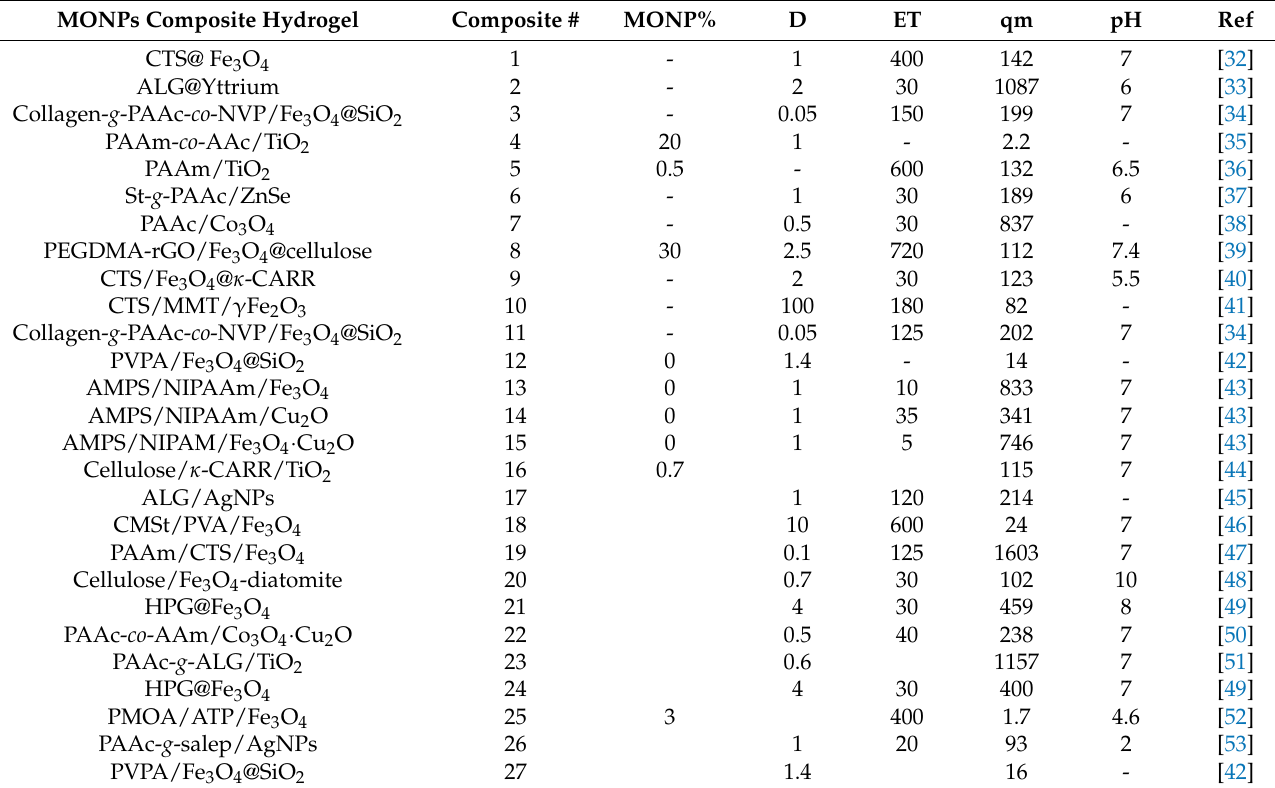
Table 1. Physical and chemical properties data of different composite hydrogels containing MONPs used for the removal of dyes from water (adapted with permission from Pereira et al. Ref [10]). MONPs Composite Hydrogel Composite